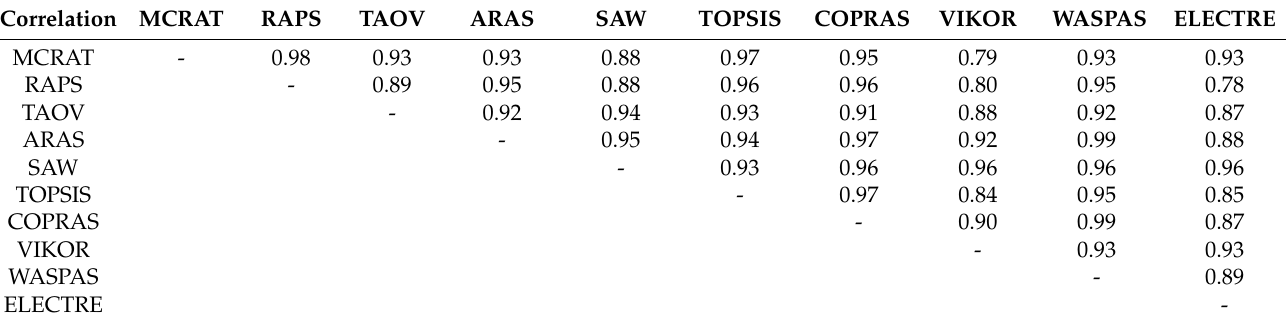
Table 6. Degree of correlation for different methods.